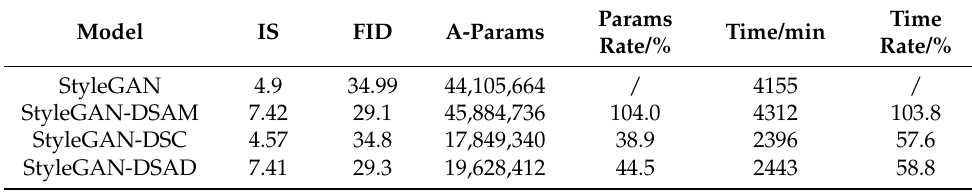
Table 1. Overall performance evaluation of the models.